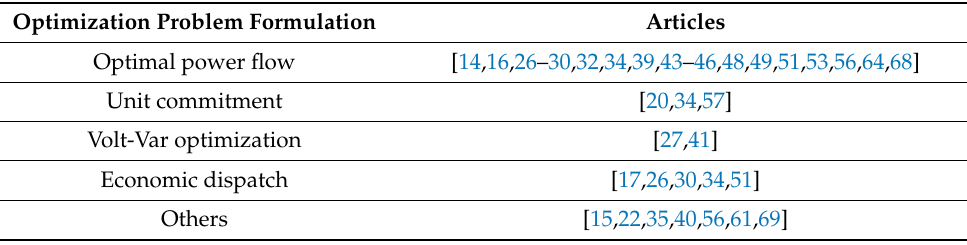
Table 3. TSO/DSO coordination optimization problem formulation.